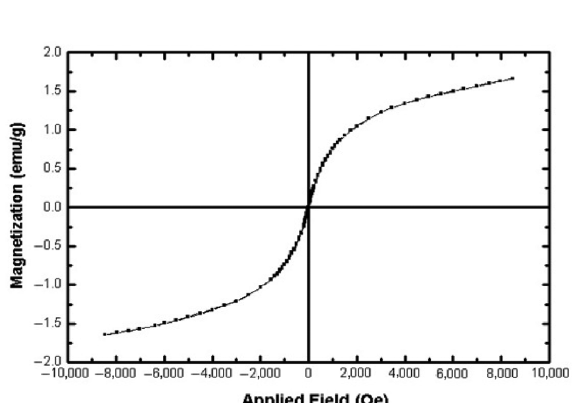
Figure 7: TEM images of BFO nanoparticle (b) is the corresponding HRTEM images of (a).